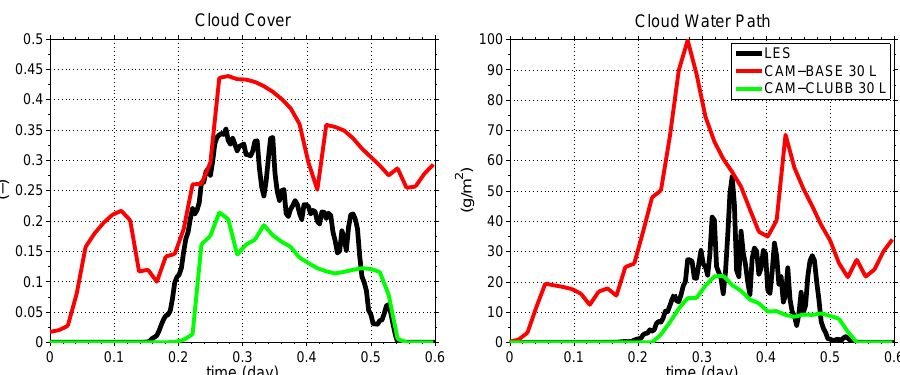
Fig. 4: Temporal evolution of the integrated low cloud fraction and liquid water path from the simulations of ARM case of continental shallow cumulus with 30 vertical levels and a 60-s time step.